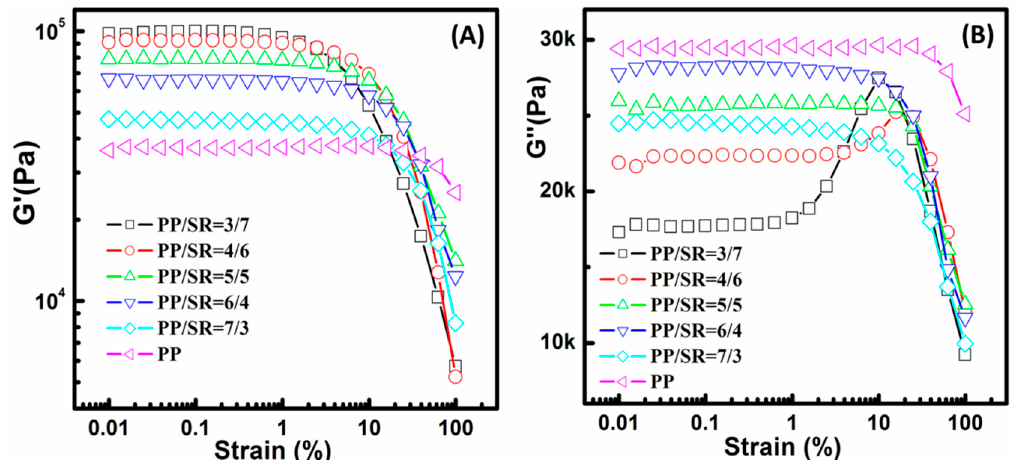
Figure 4. The dependence of the ( A ) dynamic storage modulus ( G ’) and ( B ) loss modulus ( G ”) on strain amplitude measured at 200 °C and 10 rad/s for different polypropylene (PP)/silicone rubber (SR) thermoplastic vulcanizates (TPVs).